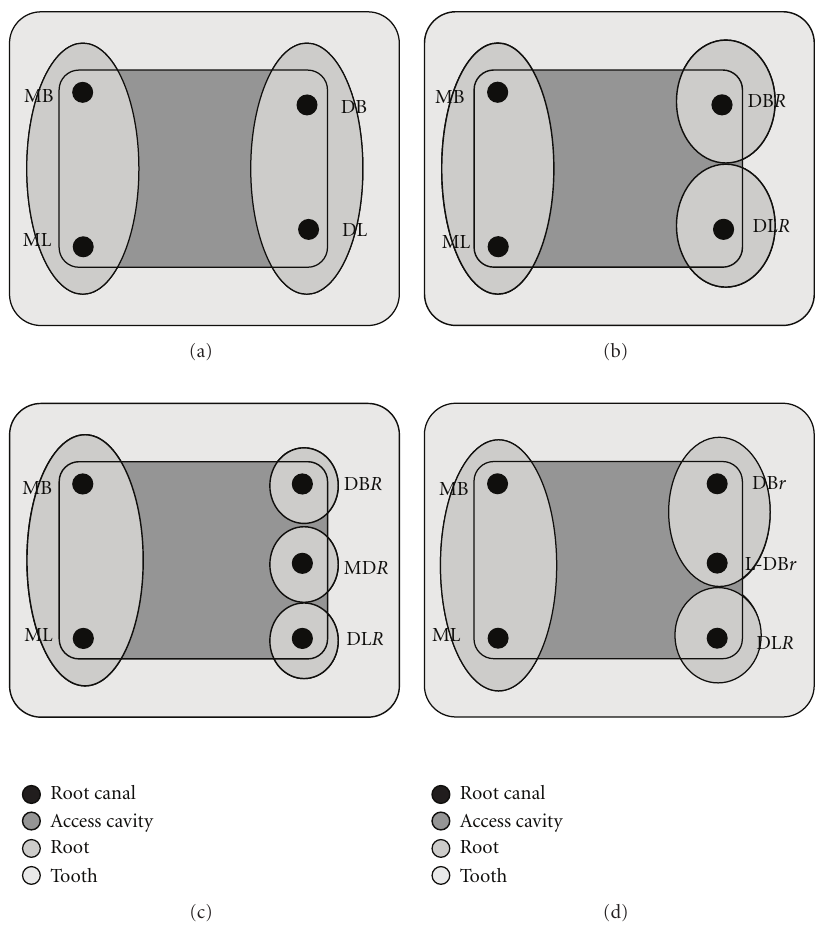
Figure 2: Diagrammatic representation of various root and canal configurations in mandibular molars named according to the proposed nomenclature. (a) Names of the canals would remain unaltered if the principle roots contain their principle canals; MB—mesiobuccal, ML—mesiolingual, DB—distobuccal, DL—distolingual or distal (D). (b) In mandibular molar with an additional distal root, the names